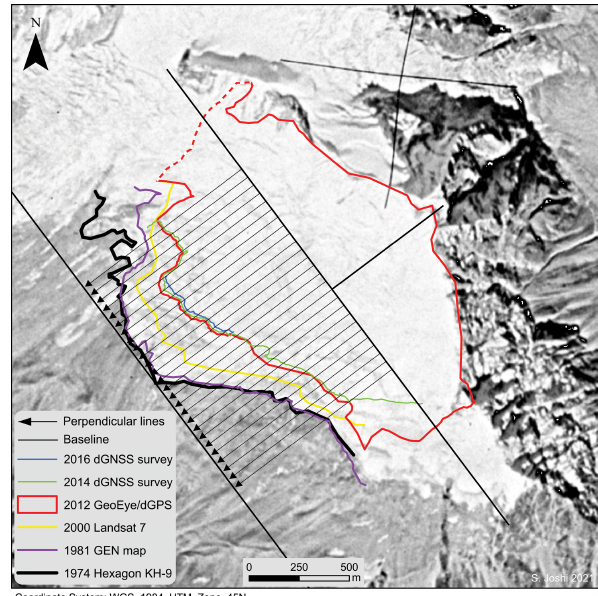
Figure 9. Frontal variations of Yala Glacier from 1974 to 2016. The general flow direction is indicated by a straight black line starting at the highest point of the glacier (north-east corner). An arbitrary baseline marks the maximum extent of 1974. Twenty-six parallel arrows in flow direction at 50m intervals were used to calculate average frontal variations, but to exclude outliers only the nine lines crossing the terminus from 2016 were used for the analysis. The background image is the Hexagon KH-9 from 1974.